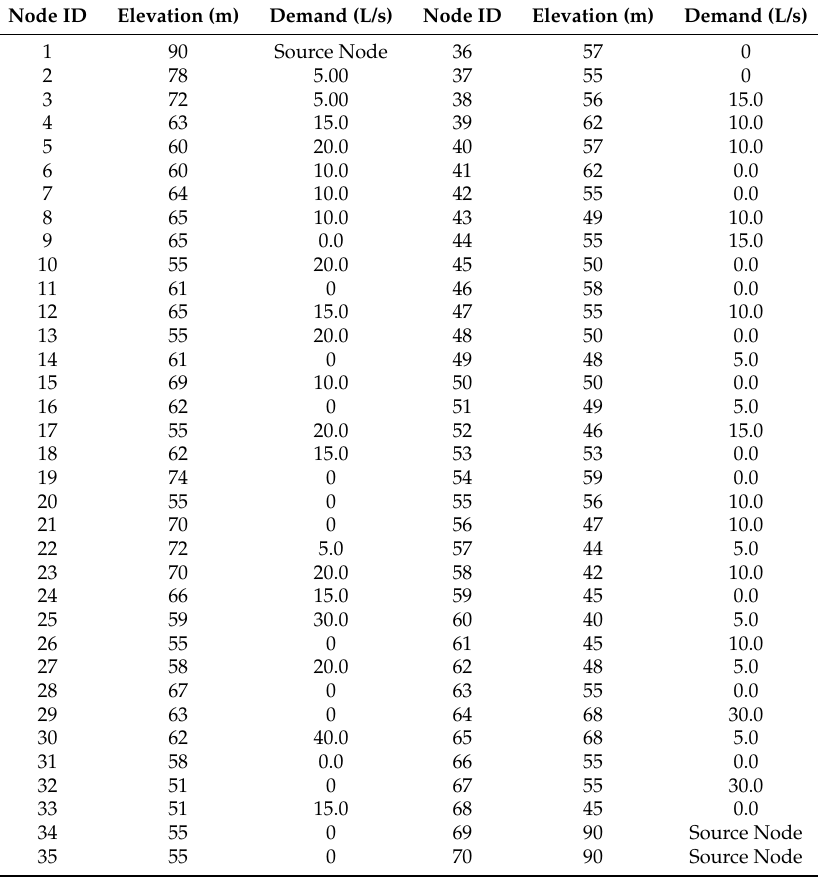
Table A4. Node data for the case study network